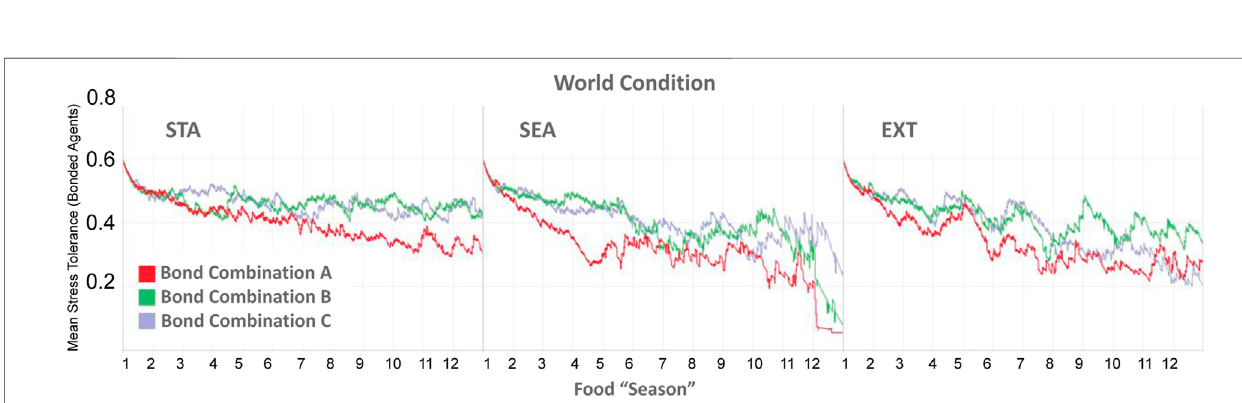
Frontiers in Robotics and AI |